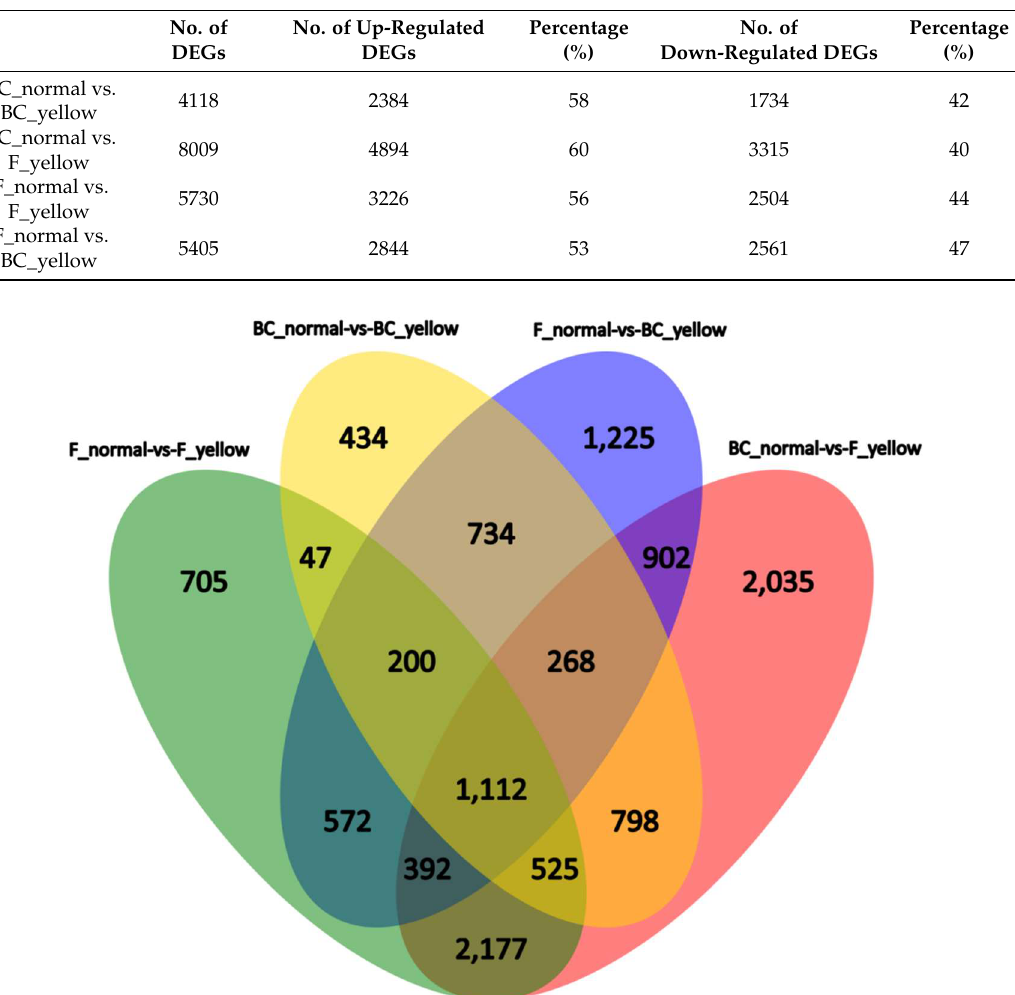
Figure 2. Venn diagram showing the numbers of overlapping and nonoverlapping DEGs (FDR < 0.01 and fold change > 2.0 or < − 2.0) in the indicated segments from normal-leaf samples and yellow-leaf samples.